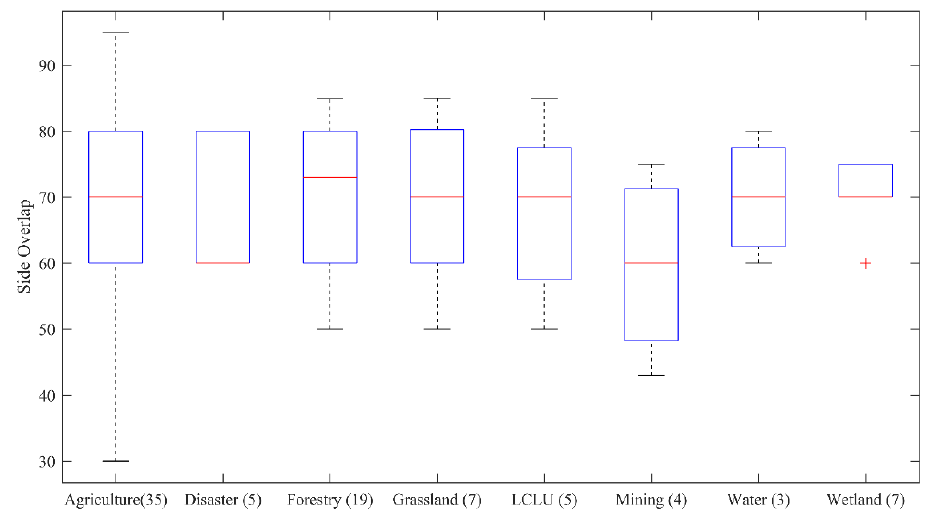
Figure 13. Side overlap distribution of UAV imagery for different applications.